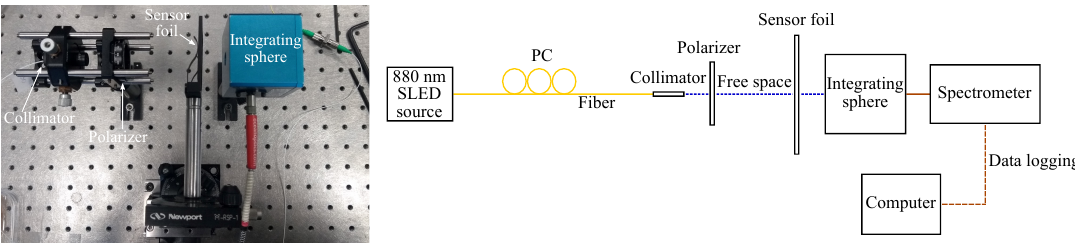
Figure 17. A picture and a schematic of the setup in transmission. PC = polarization